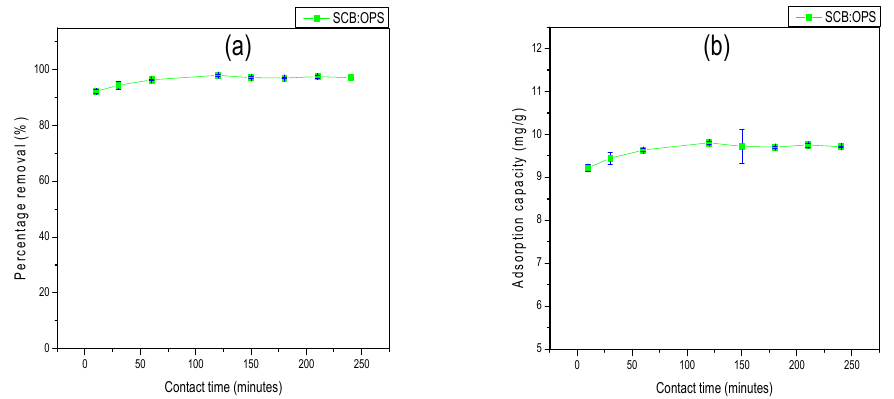
Figure 10. Effect of contact time: ( a ) 20 mg/L Pb(II) percentage removal and ( b ) 20 mg/L Pb(II) adsorption capacity.